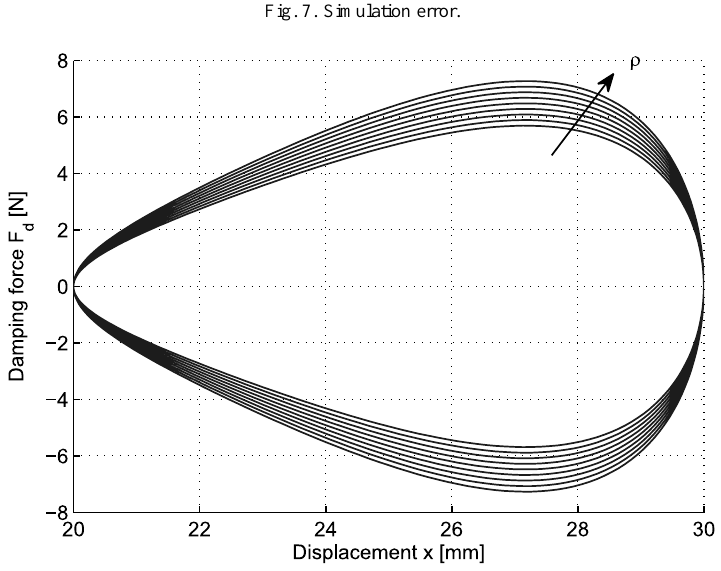
Fig. 8. Prediction of course of damping